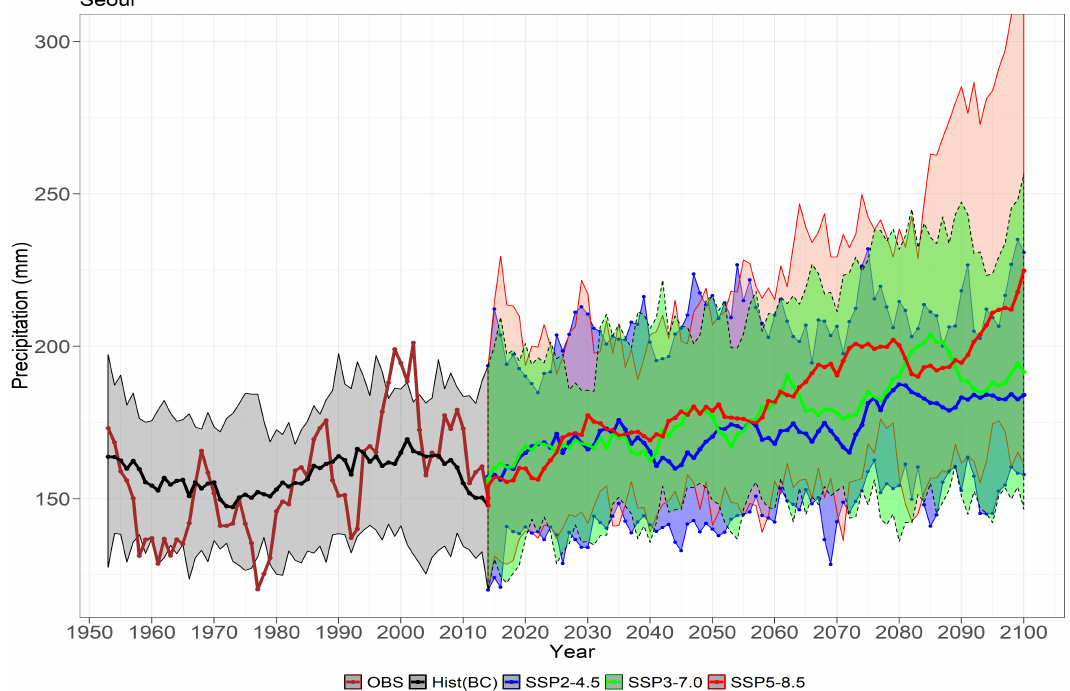
Figure 6. Time series plots of the nine-year moving averages of the annual maximum daily precipitation in Seoul from the observations (red line) and from the PI-weighted ensemble of the bias-corrected historical data (black line) of the 21 CMIP6 models for the past years (1953–2014) and the PI-weighted ensembles for the bias-corrected future data from the three shared socioeconomic pathway (SSP) scenarios, with a 90% confidence band. The blue line is for SSP2-4.5, the green line is for SSP3-7.0, and the red line is for